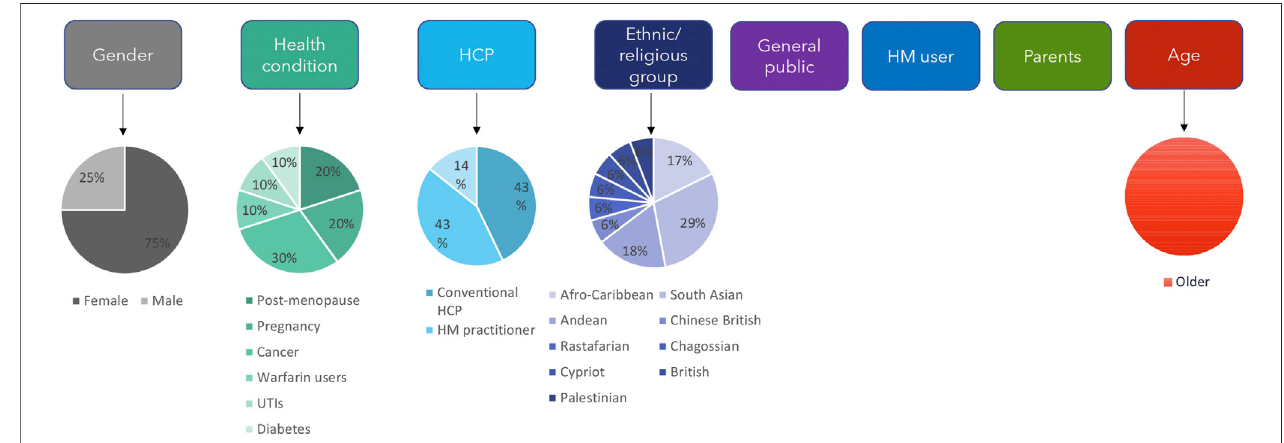
FIGURE1| Key population themes and sub-themes. Thedifferentpopulation themes forthe studies areshown alongthetop. Age, gender, health condition, HCP and ethnic/religious group are further divided into sub-themes; shown by the pie charts below them that indicate the relative numbers of studies for each sub-theme. HCP: healthcare professional, HM: herbal medicine, UTIs: urinary tract